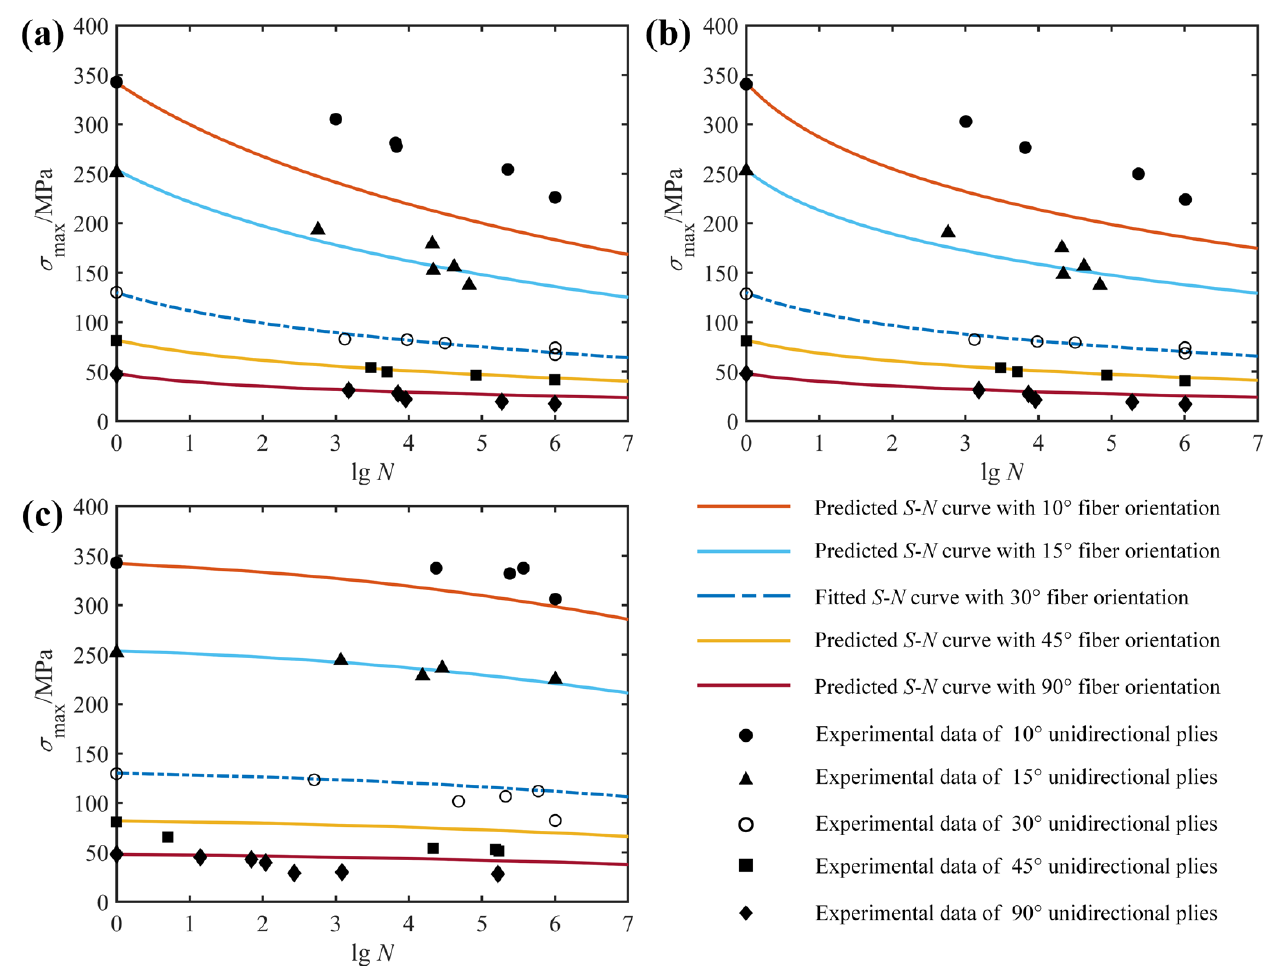
Figure 7. Fitted (30°) and predicted (other angles) S - N diagrams of unidirectional T800H/2500 specimens, together with experimental data from Ref. [30]: ( a ) R = −1; ( b ) R = 0.1; ( c ) R = 0.5.